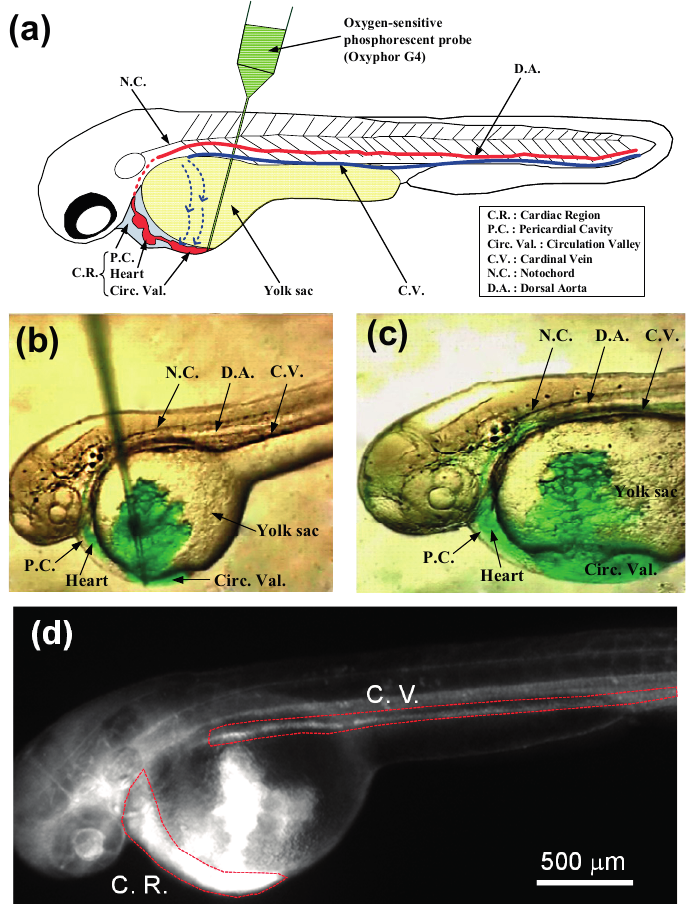
Figure 3. ( a ) A schematic of anatomical features of 48 hpf zebrafish embryos from